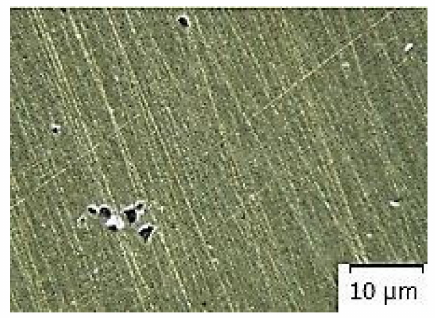
Figure 8. Microscopic evaluation of sample 2/ ×